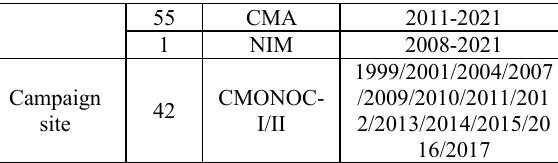
Table 1 . Data sources and observation frequency.